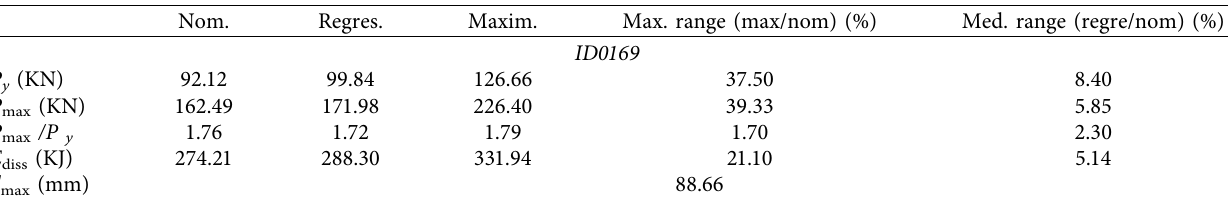
Figure 11: ID5779: applied displacements (a) and hysteresis curves (b). Table 5: Results of mean of values